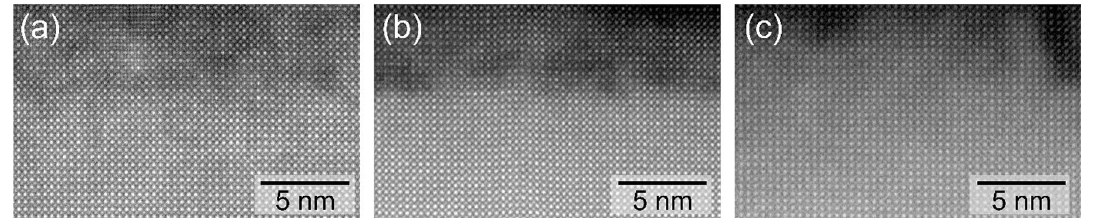
Figure 2. STEM HAADF images for samples with Sr/Ti ratio of ( a ) 2.6, ( b ) 3.2 and ( c ) 3.6 for a camera length of 196